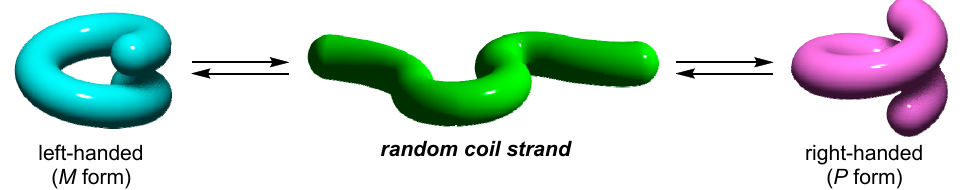
Figure 2. Interconversion between P and M forms of a helical structure via a random coil structure.